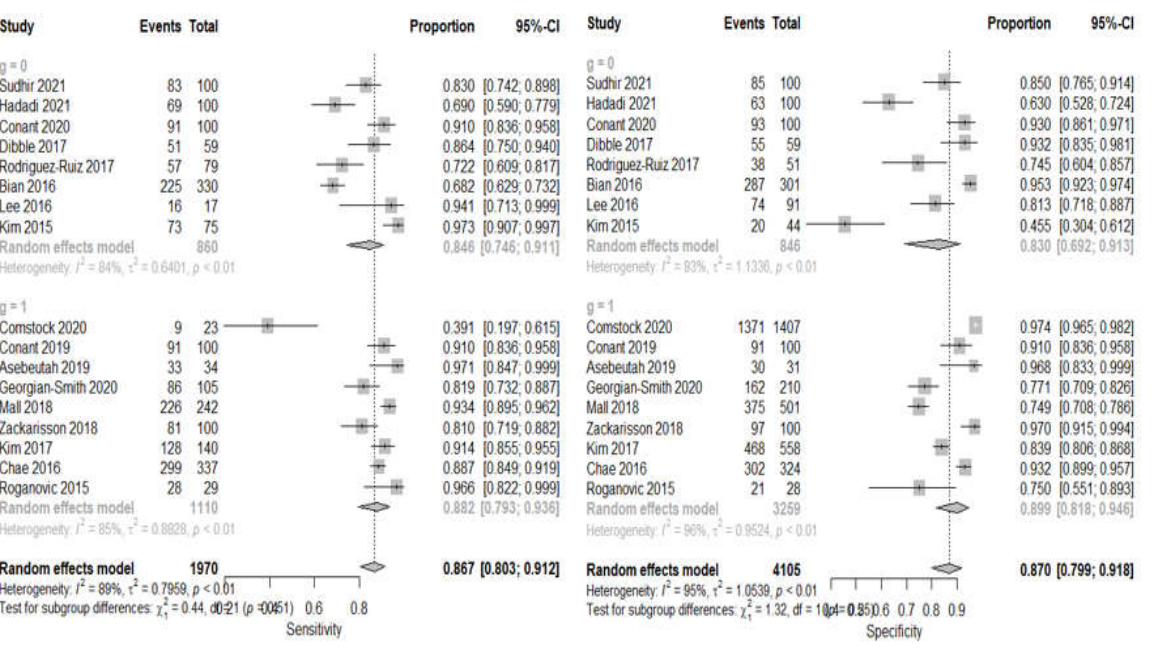
Figure A1. Univariate sub-group analysis of sensitivity and specificity with random model based on the different study protocols. g represents sub-group analysis of data when g = 0 (Retrospective studies) and g = 1 (Prospective studies).